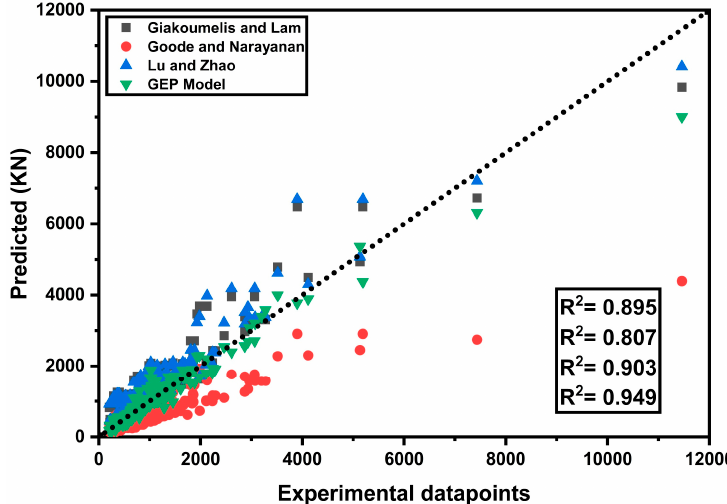
Figure 7. Comparison of GEP model with other published equations [78–80].